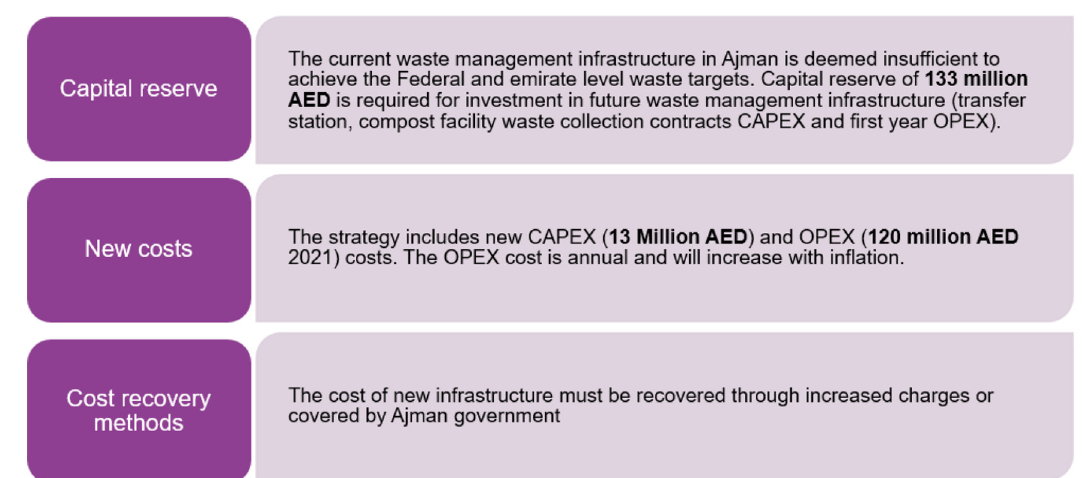
Fig. 12. Cost strategy and fi nancial framework.